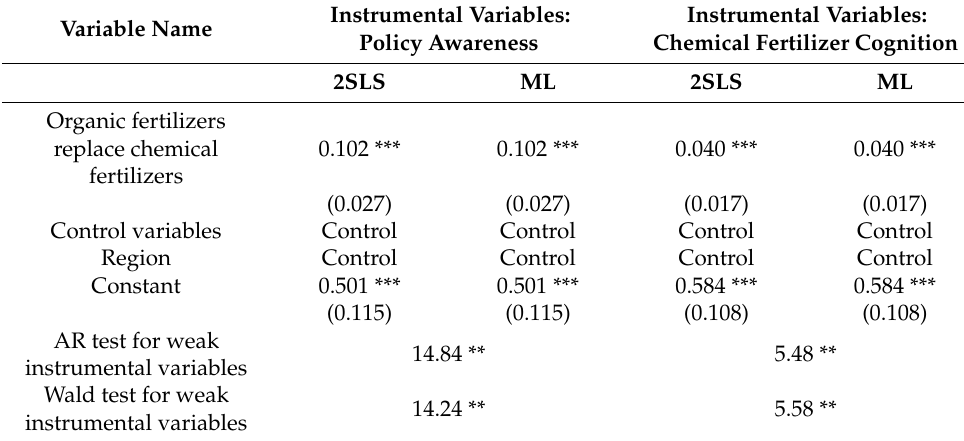
Table 8. Estimation results based on the IV-Tobit